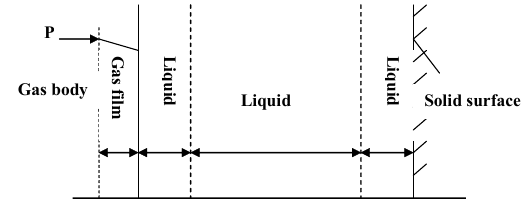
Figure 6. Sketch map for distribution of concentration in gas-liquid- solid